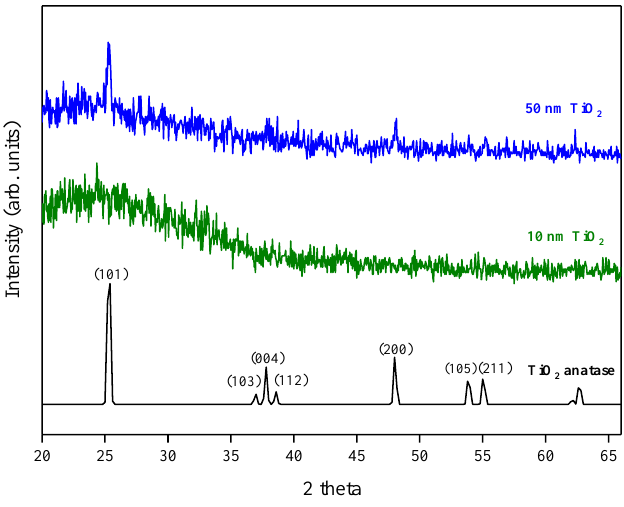
Figure 8. XRD pattern for 10 nm and 50 nm TiO 2 films deposited by ALD. A typical anatase reference pattern is also included [PDF 01-071-1166].